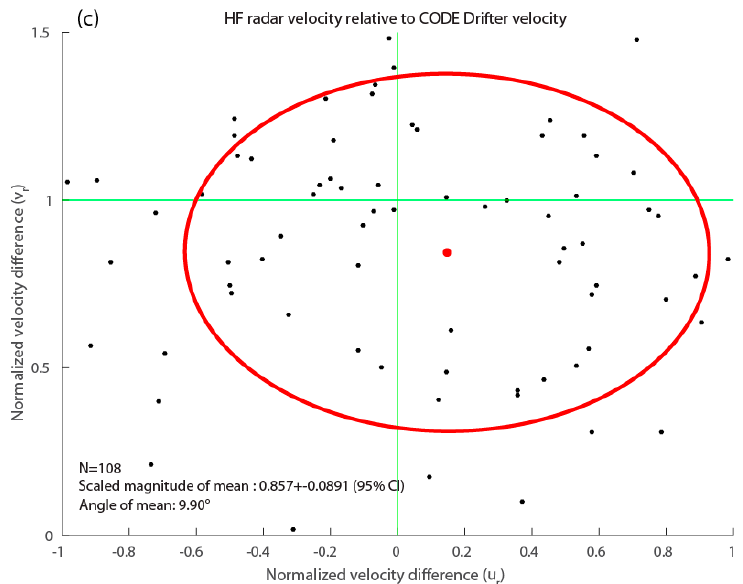
Figure 7. HF radar velocity relative to binned 5-cm ( a ), 10-cm ( b ) and CODE-style ( c ) drifter velocity ( u r , v r ), as calculated by Equation (1). The red dots are centroids of the scatter points and the red ellipses represent the standard deviations of the scatter points. Listed on each plot are the number of co-located observations (N), the angle clockwise from vector (0,1) to the centroid (mean), and the magnitude of the mean with 95% confidence interval.